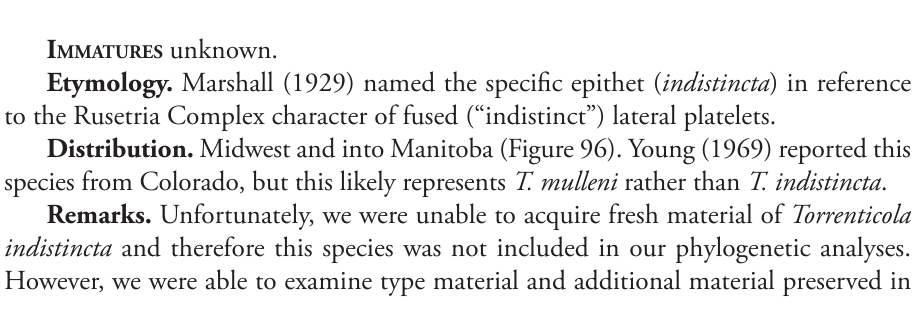
Figure 98. Torrenticola indistincta male: A dorsal plates B venter (legs removed) C subcapitulum D pe- dipalp (setae not accurately depicted). Scale = 100